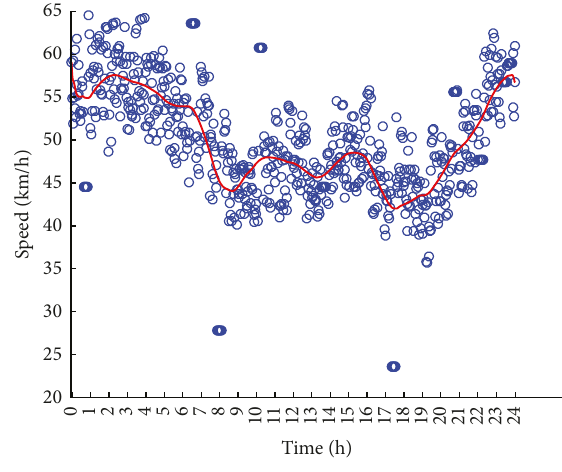
Figure 1: Traffic speed data and its smooth curve.